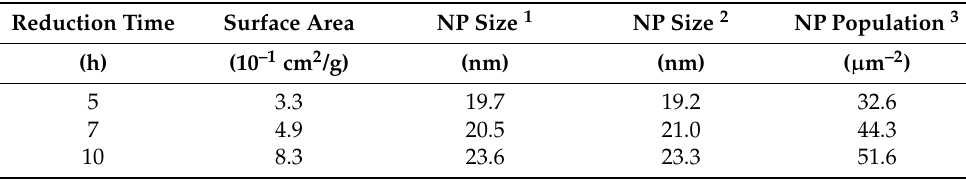
Table 1. Physical characteristics of the reduction-treated LNF samples.